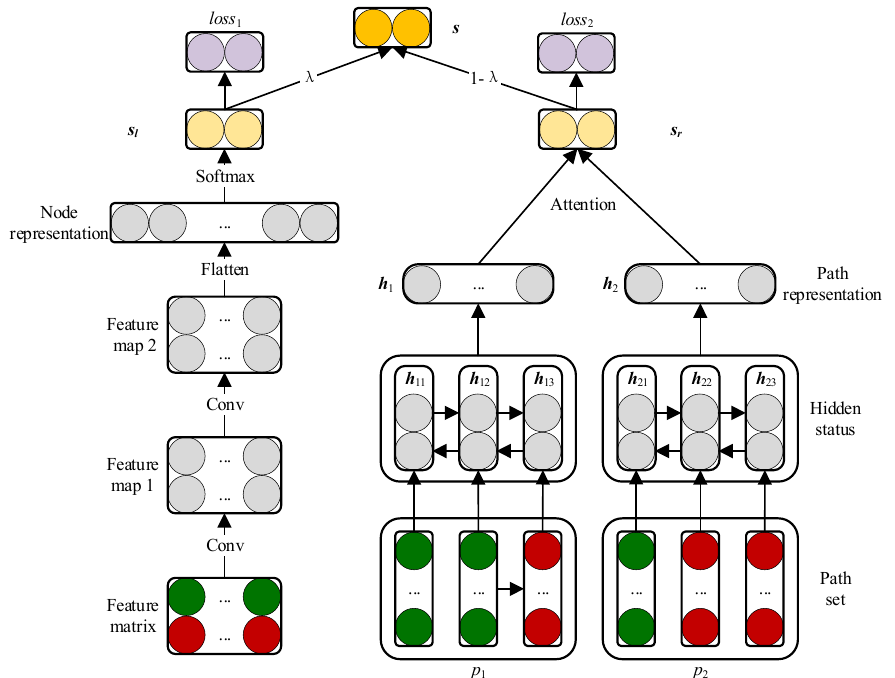
Figure 2. Construction of the framework based on the convolutional neural network and bidirectional long short-term memory for learning the original and path representations.